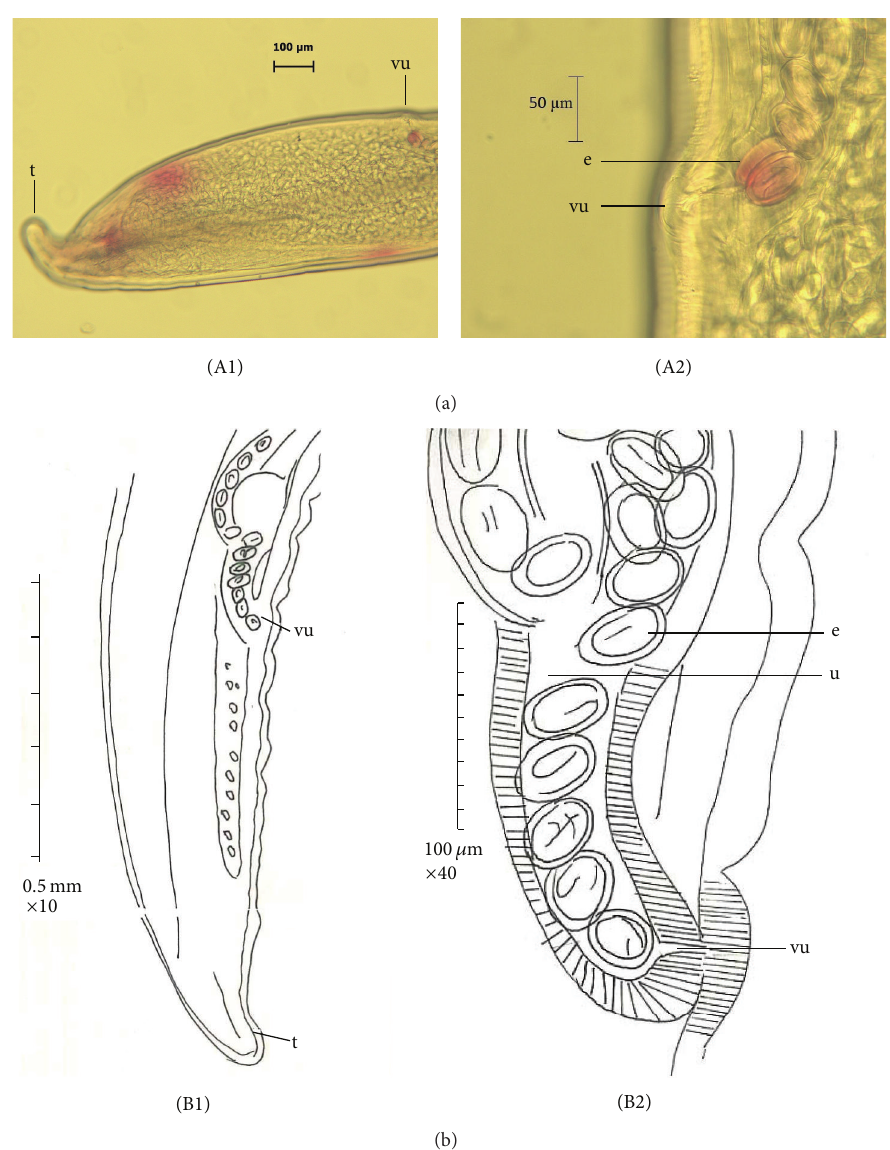
Figure 3: Female of Cheilospirura hamulosa ; light micrographs and camera lucida. (A1) Female posterior end, showing vulva (vu), tail (t); (A2) enlarged view of the female posterior region, showing vulva (vu), embryonated eggs (e); (B1) and (B2) posterior end of female, vulva (vu), utri (u), egg (e), and tail